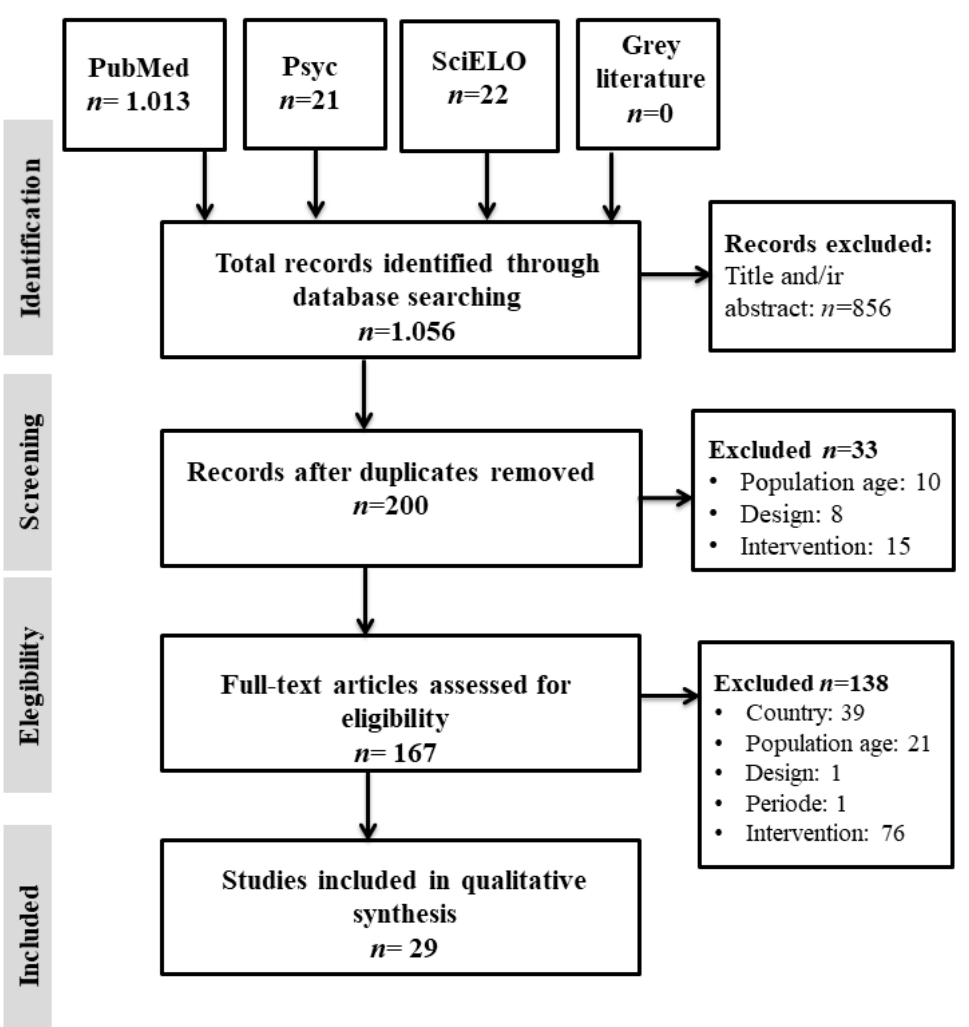
Figure 1. PRISMA flow chart.